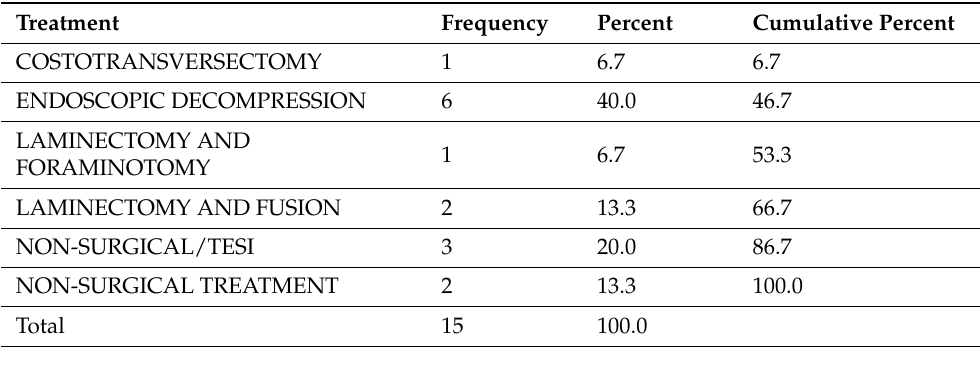
Table 3. Surgical treatment and encountered